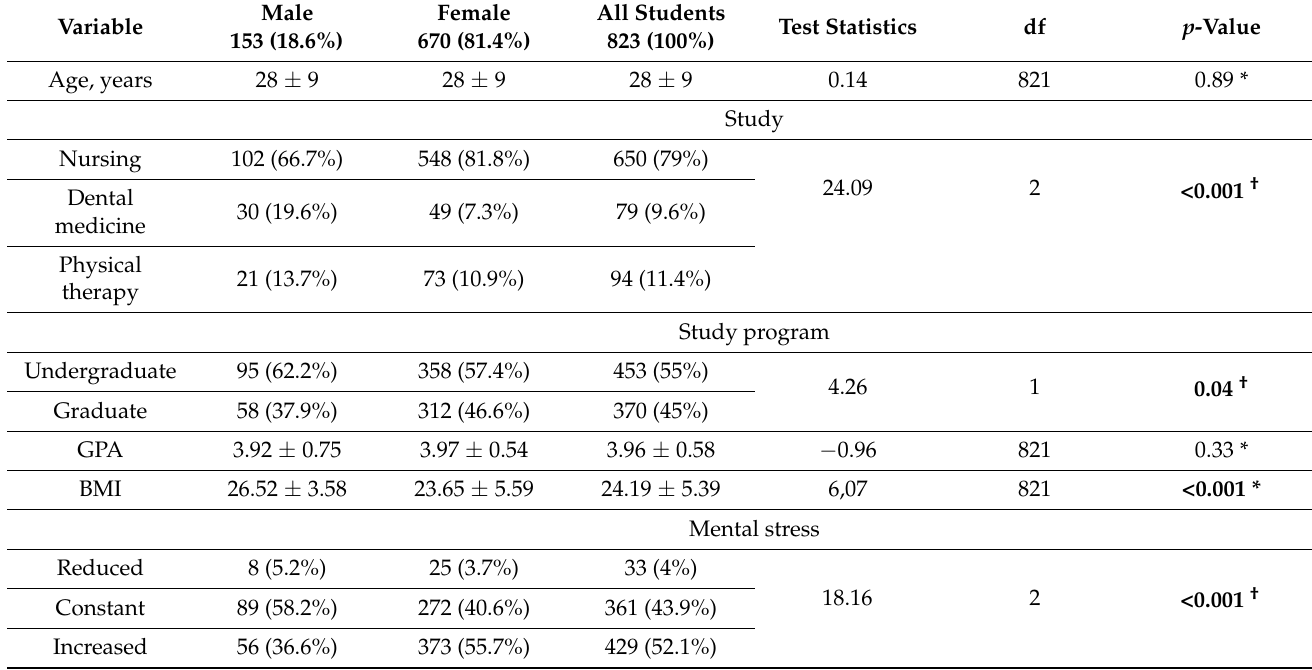
Table 5. Socio-demographic data and self-assessment of mental stress and physical activity according to